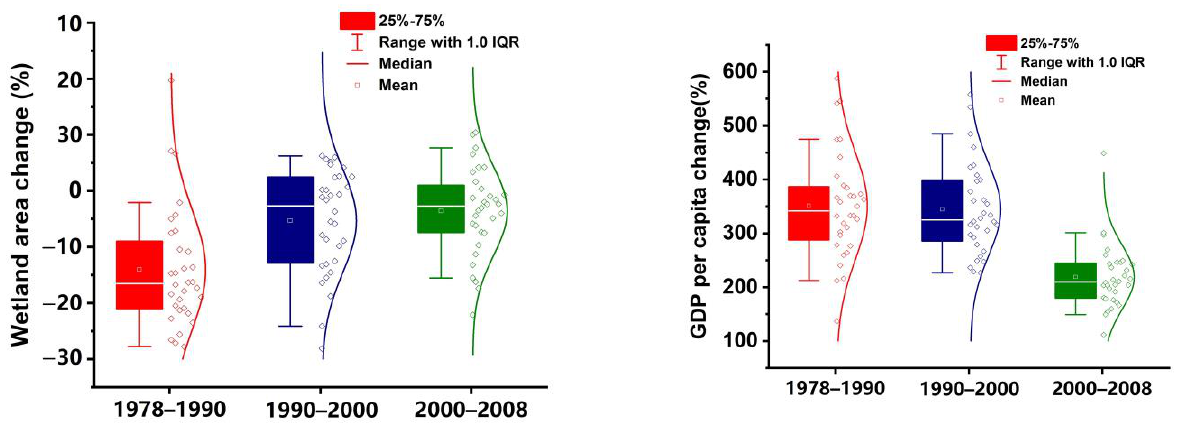
Figure 1. Changes in wetland areas ( left ) and average GDP per capita ( right ) in 31 regions of China during the three decades.